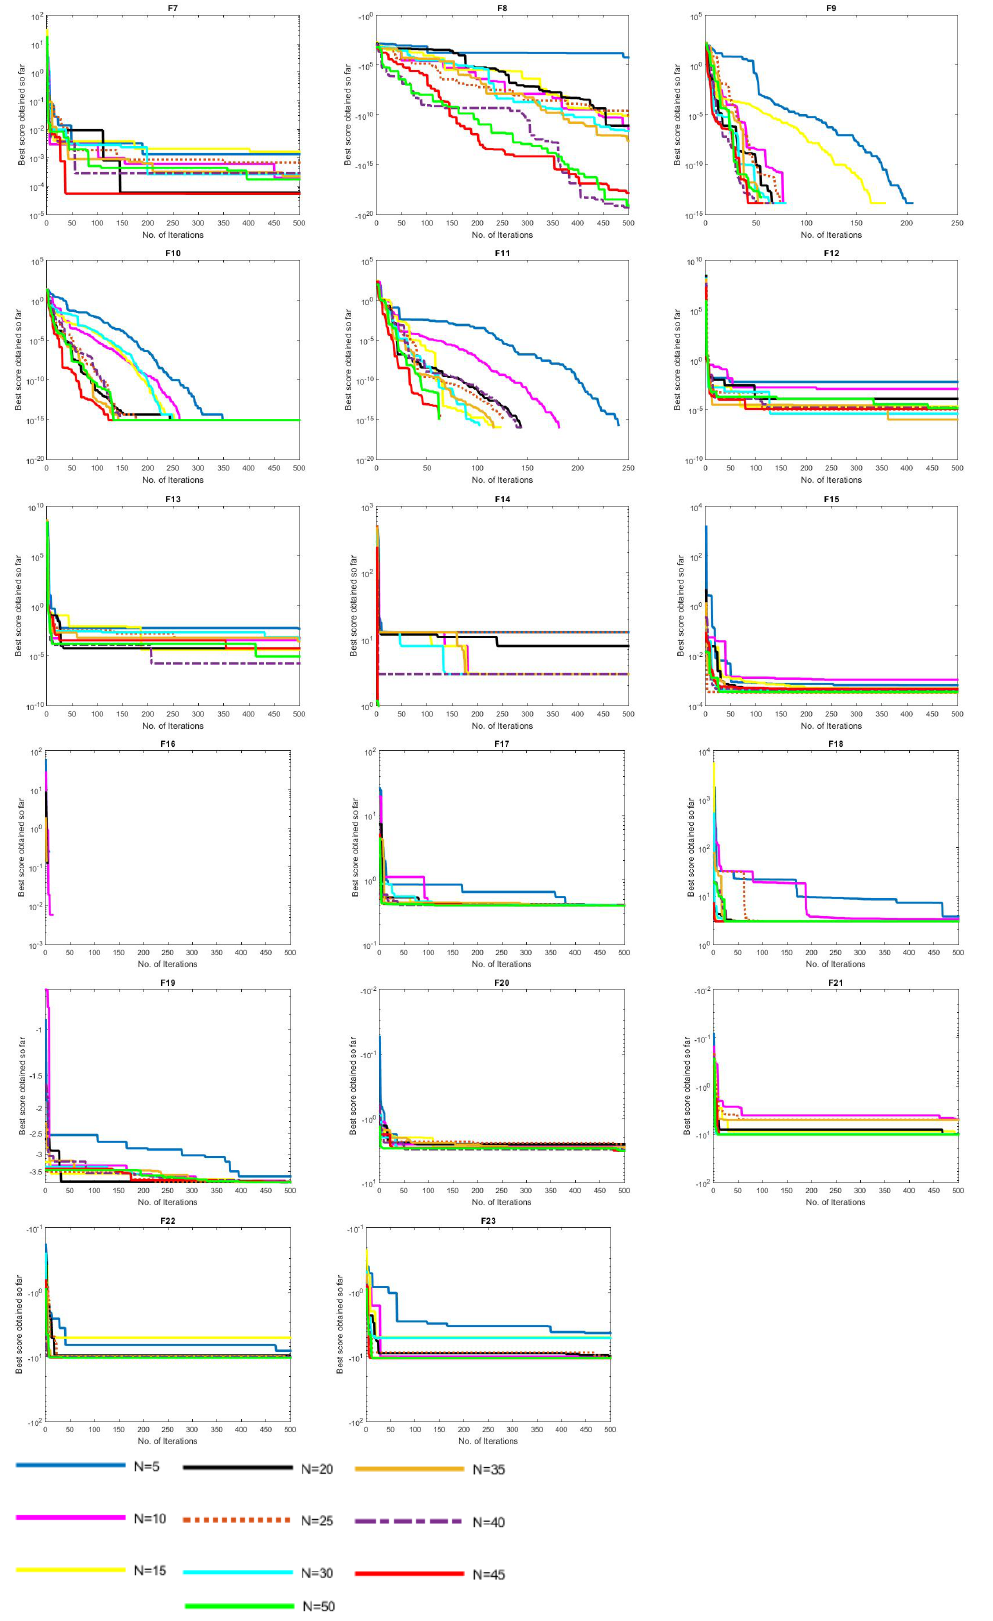
Figure 5. The influence of the population size tested on the classical test